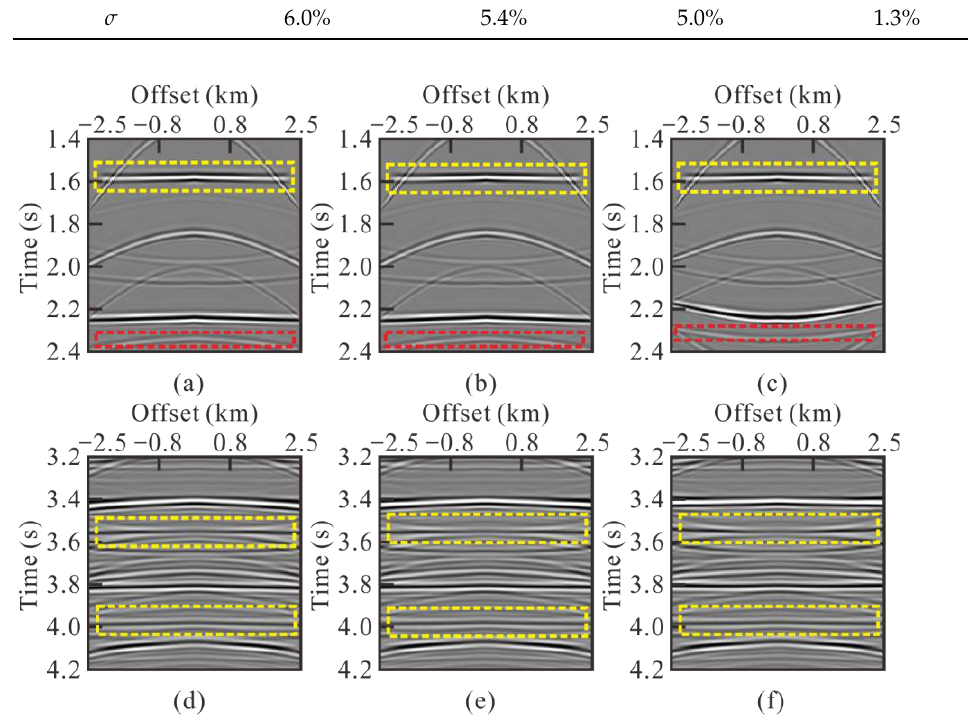
Figure 7. NMO comparison results . 1.4 – 2.4 s : ( a ) NMO results of the MP velocity, ( b ) NMO results of the AD velocity, ( c ) NMO results of the MA velocity. 3.2 – 4.2 s : ( d ) NMO results of the MP velocity, ( e ) NMO results of the AD velocity, ( f ) NMO results of the MA velocity. Within 3.2 – 4.2 s, the primary events were basically flattened (marked by yellow dot-